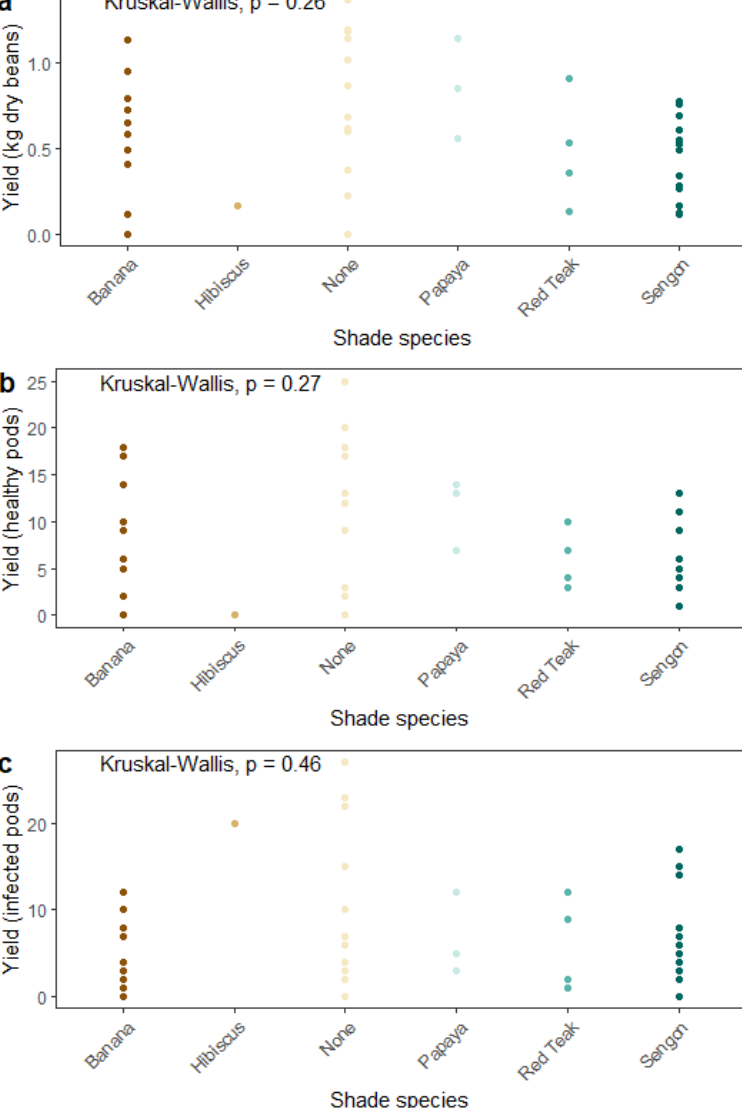
Figure 4. Effects of shade tree presence and identity on cacao yield metrics. ( a ) Dry beans, ( b ) healthy pods, and ( c ) infected pods did not differ significantly according to presence or species of the nearest shade tree. “None” indicates yields of cacao trees without neighboring shade trees (Cacao-Cacao